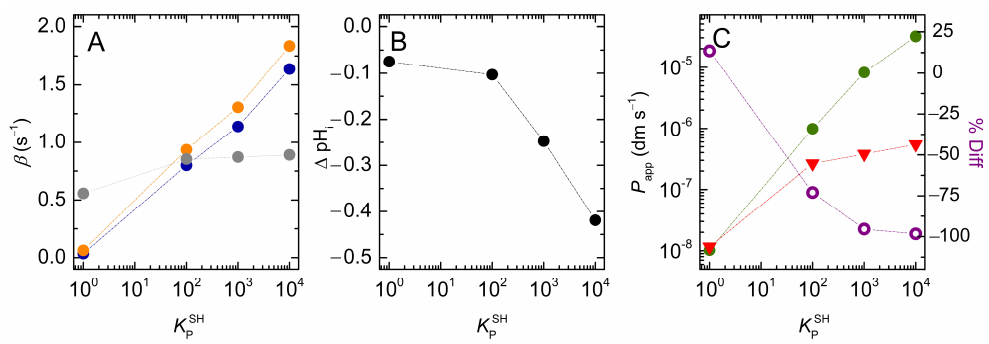
Figure 10. Effect of solute lipophilicity on: ( A ) the equilibration characteristic constant, for non- ionisable solutes ( • ) and weak acids ( • ), and ratio between the two ( • ); ( B ) the pH gradient generated at equilibrium by the permeation of the weak acids; and ( C ) the calculated permeability coefficient ( P app • , P r app (cid:72) ), and % difference (100 × ( P r app − P app )/ P app ). Note the logarithmic scale of the x (cid:35) axis of all plots, and of the y axis in ( C ). The dotted lines are guides for the